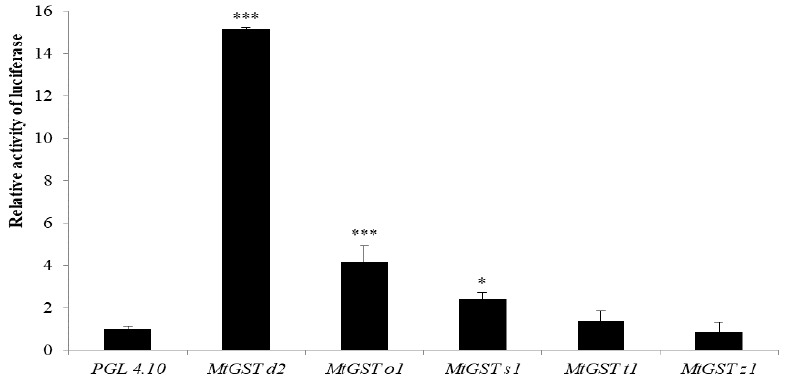
Figure 3. The promoter activity was measured as luciferase activity in Sf9 cells. * on the bars indicate that the means are significantly di ff erent between the control and MtGST promoters (*** means P < 0.001, * means P <